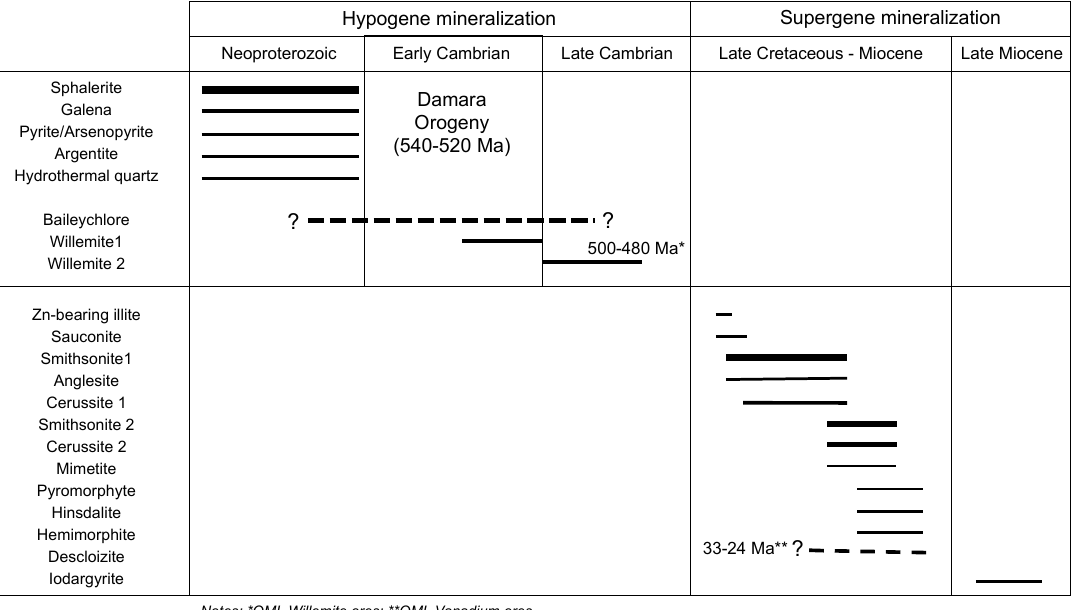
Figure 11. Mineral paragenesis of the Zn-Pb mineralization in the Kihabe area. Absolute ages after * [30], and ** [31].